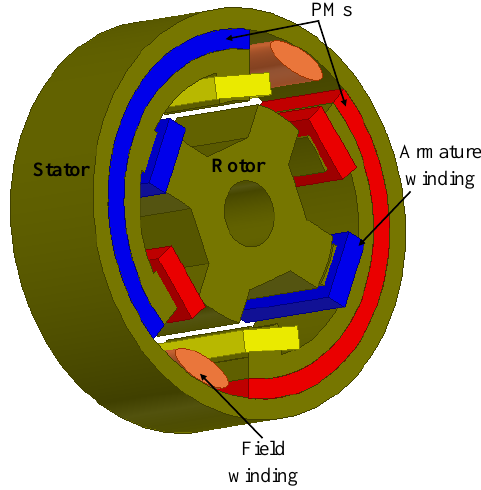
Figure 5. A 6/4-pole doubly salient hybrid-excited motor.